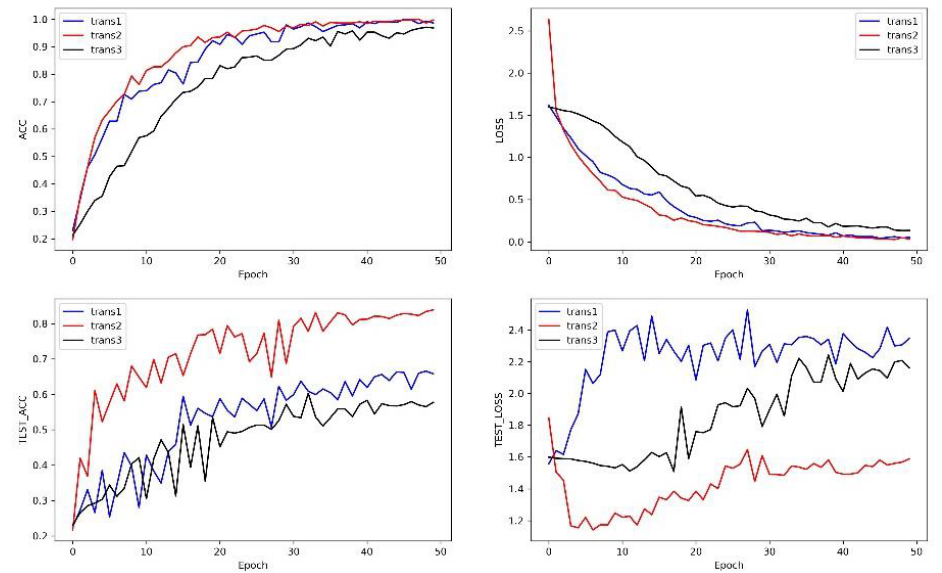
Figure 19. Comparison of three transfer methods under 0.375 data size.